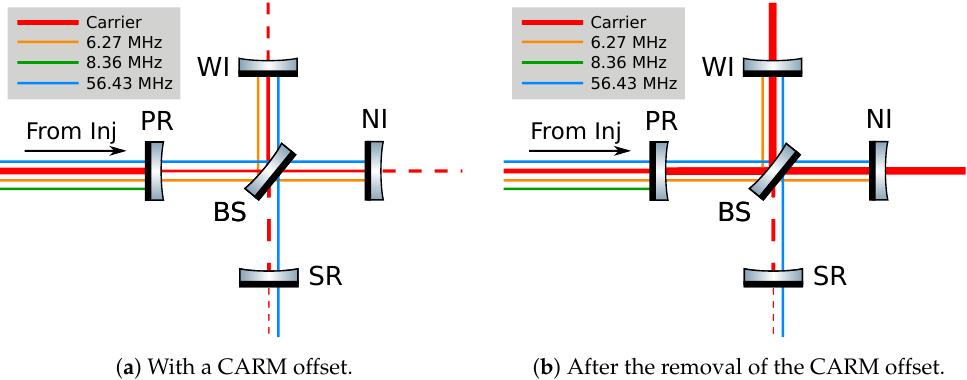
Figure 2. Resonance conditions of the control sidebands in the DRMI. The red line shows the path of the carrier beam, while the other colored lines correspond to the field of a specific sideband.